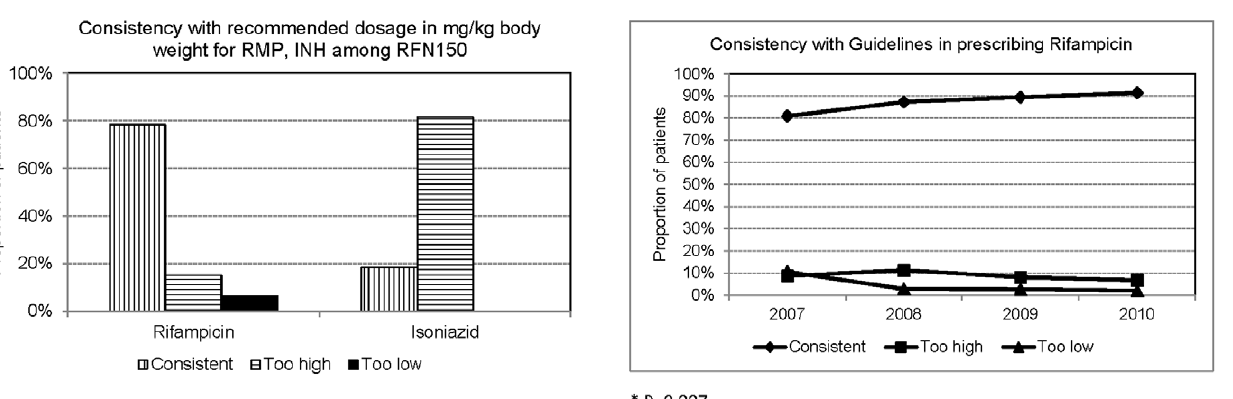
Figure 4. Consistency with recommended dosage in mg/kg body weight for Rifampicin 8 – 10 mg/kg) and Isoniazid (4 – 6 mg/kg) among those prescribed Rifinah150.